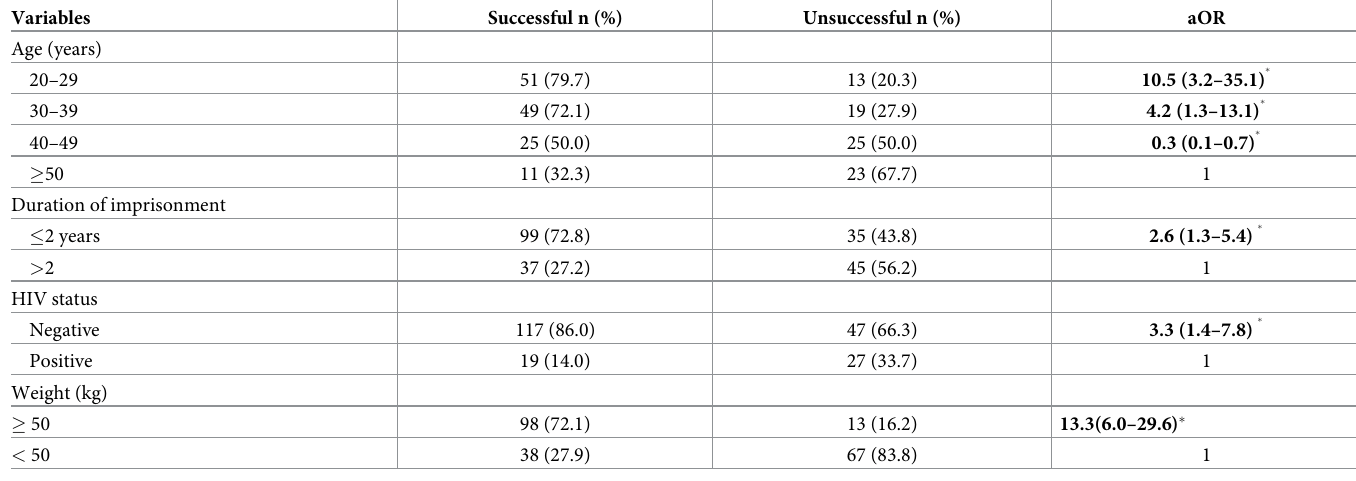
Table 3. Factors associated with successful treatment outcome of tuberculosis in five main prison settings in Bauchi State from January 2014 to December 2018 according to multivariate analysis.